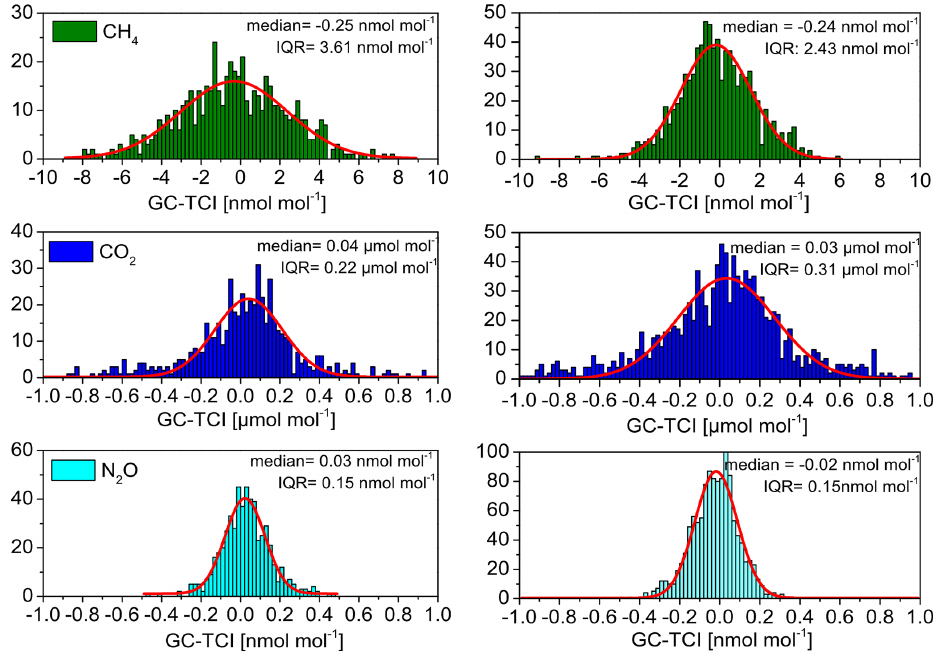
Figure 5. Distributions of the mole fraction differences measured with the GC-HEI and the TCI in Heidelberg (both with separate intake lines) from 25 January 2013 until 13 February 2013 (left panels) and from the 1 June 2013 to the 1 July 2013 with the same intake line (right panels). The red lines are Gauss fits to the distributions, IQR stands for interquartile